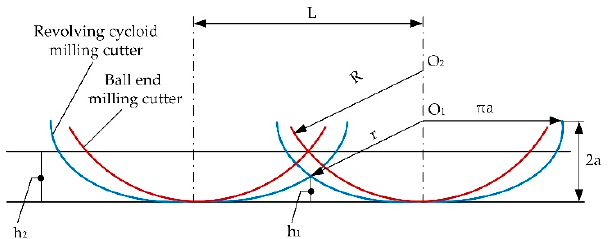
Figure 5. Comparison of scallop height of two kinds of milling cutters.